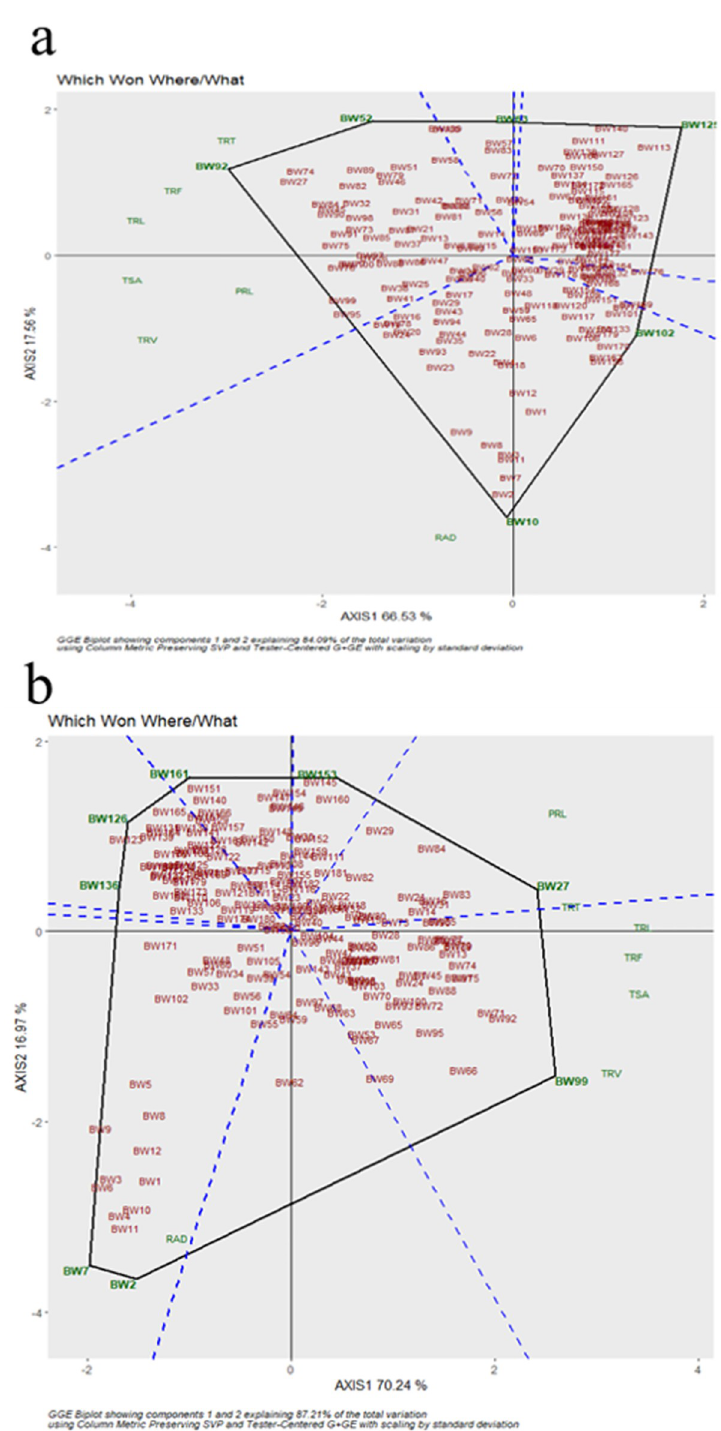
Fig 4. Which-won-where view of GGE biplot to show which genotype performed better for which trait under in (a) non-limiting and (b) limiting phosphorus conditions.